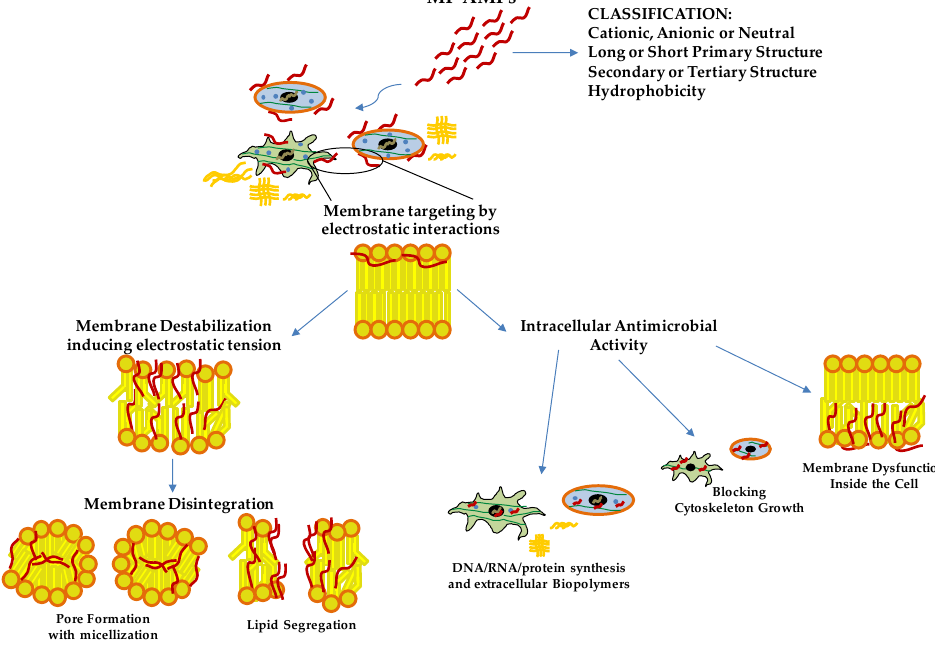
CLASSIFICATION: Cationic, Anionic or Neutral Long or Short Primary Structure